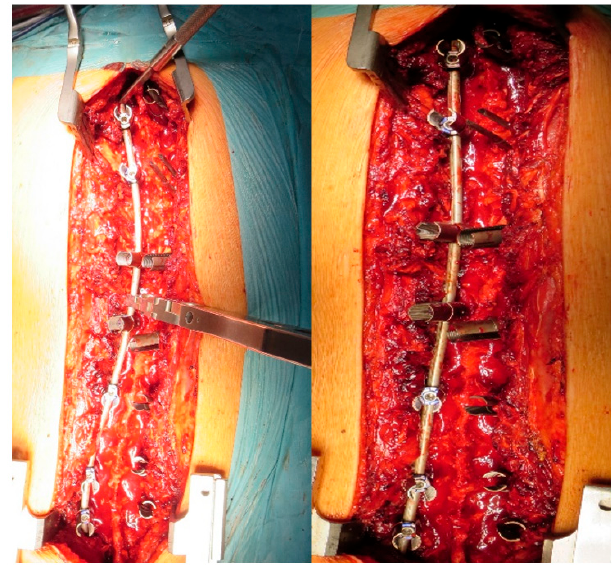
Figure 3. Intraoperative view of AIS correction maneuvers.